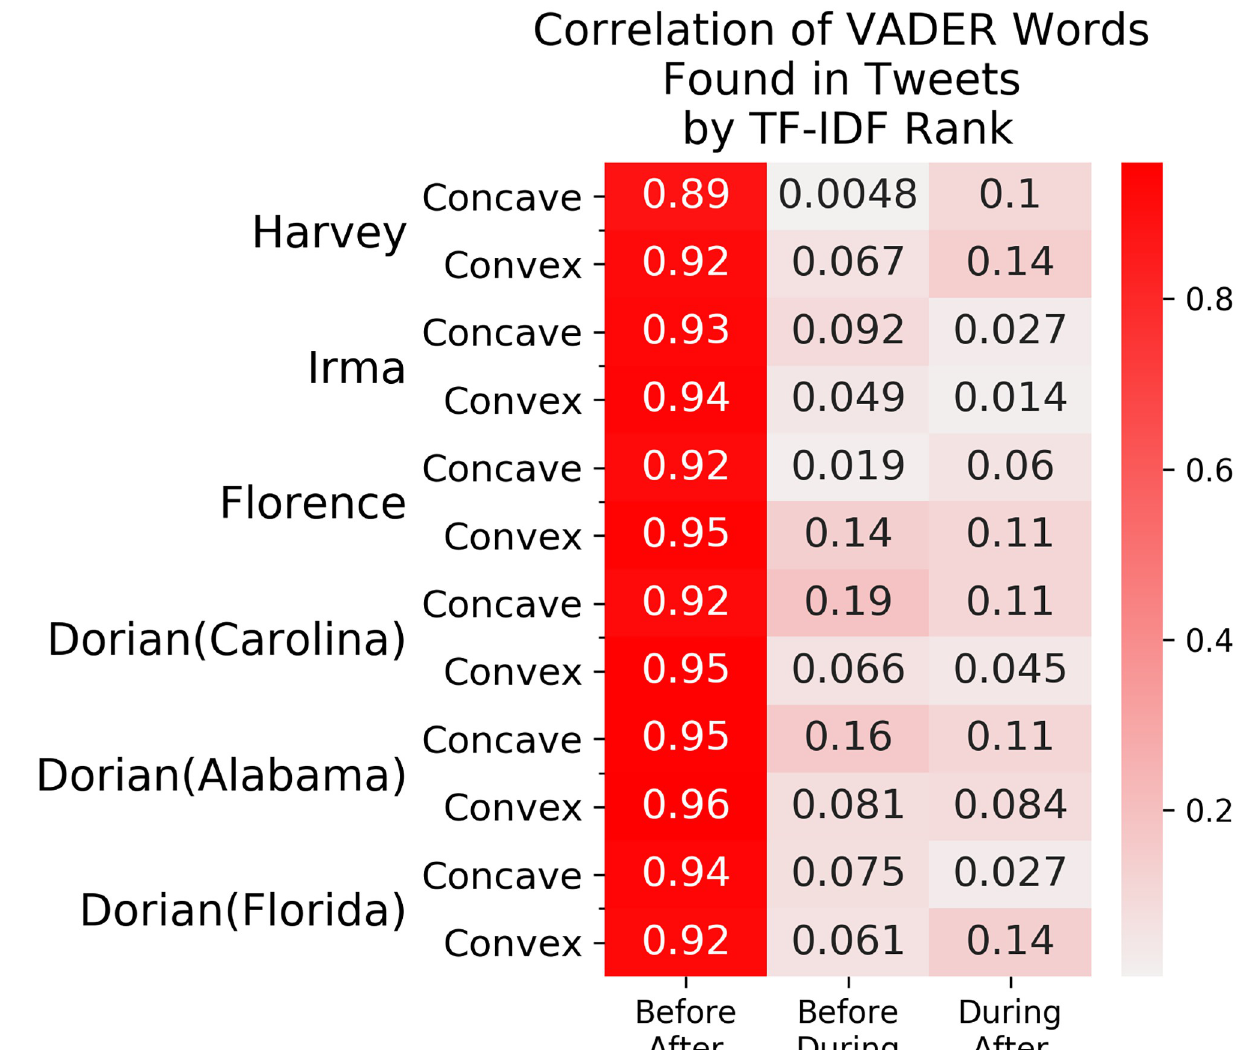
Fig 7. Rank order correlation of VADER words by TF-IDF. The Kendall rank correlation coefficient is a measure of correlation between two orderings. A high correlation between orderings of TF-IDF values of VADER terms from two time periods indicates a similar ranking of the VADER terms between the two time periods. The correlation between the before and after orderings are almost 1, indicating a near perfect similarity in the word rankings. On the other hand, all of the calculated correlations involving the during orderings are almost 8–9x less, indicating that the hurricane had an effect on the usage of VADER terms in